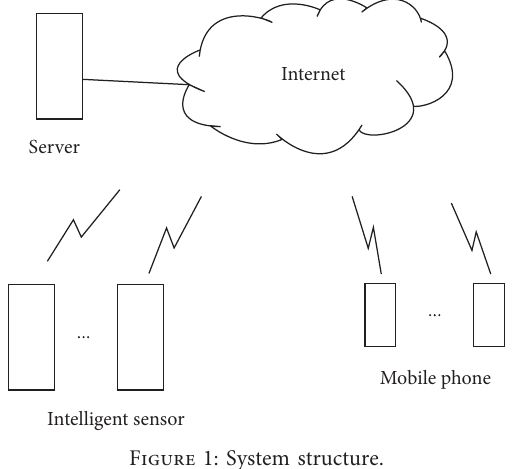
Figure 1: System structure.